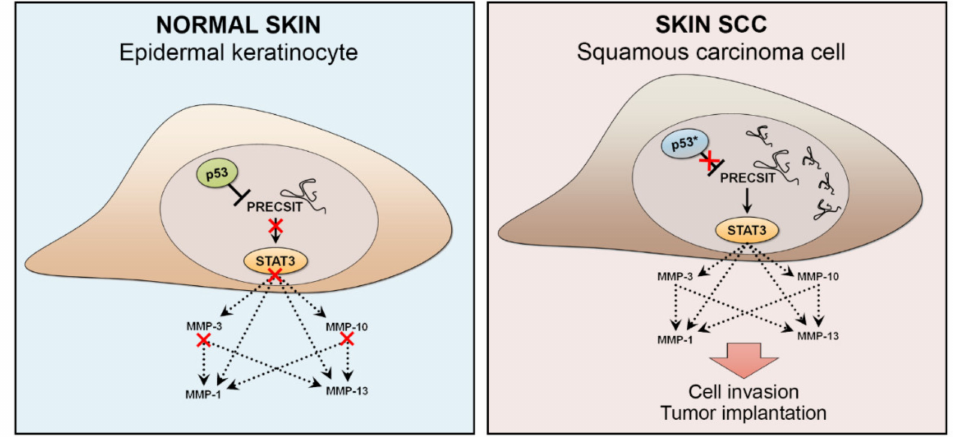
Figure 5. PRECSIT is a p53-regulated lncRNA with a tumorigenic role in cutaneous squamous cell carcinoma (cSCC). Proposed molecular model for the mechanistic role of PRECSIT in cSCC; low level of PRECSIT expression is maintained in normal epidermal keratinocytes by p53. The red cross indicates blockage of the downstream signaling. In cSCC cells, mutational inactivation of p53, which leads to loss of p53 expression, results in upregulation and accumulation of PRECSIT in the nucleus. Elevated PRECSIT expression contributes to STAT3 activation and up-regulation of matrix metalloproteinases collagenase-1 (MMP-1), collagenase-3 (MMP-13), stromelysin-1 (MMP-3), and stromelysin-2 (MMP-10). MMP-3 and MMP-10 are capable of degrading several extracellular matrix (ECM) components, including basement membrane type IV collagen, fibronectin, and laminin. They also activate latent collagenases MMP-1 and MMP-13, capable of cleaving fibrillar collagens type I and III in the dermal ECM. The proteolytic remodeling of ECM and the basement membrane by MMPs is essential for cSCC cell invasion and tumor cell